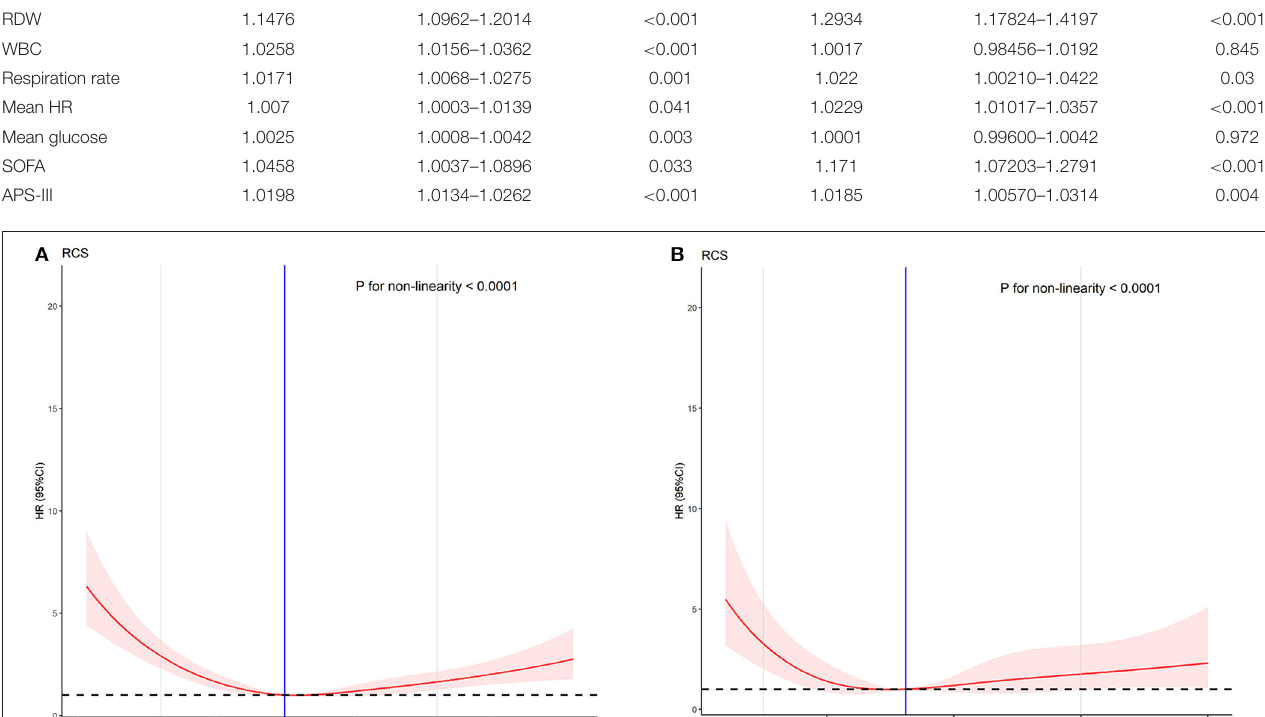
FIGURE 3 | The effect of SBP on the prognosis of AMI between different age groups. (A) Low-age group (age ≤ 65). (B) High-age group (age > 65).